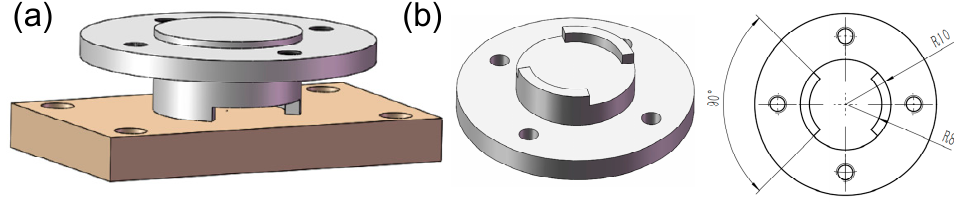
Figure 2. Schematic diagram of: ( a ) contact between the upper and lower specimens; ( b ) upper specimen.